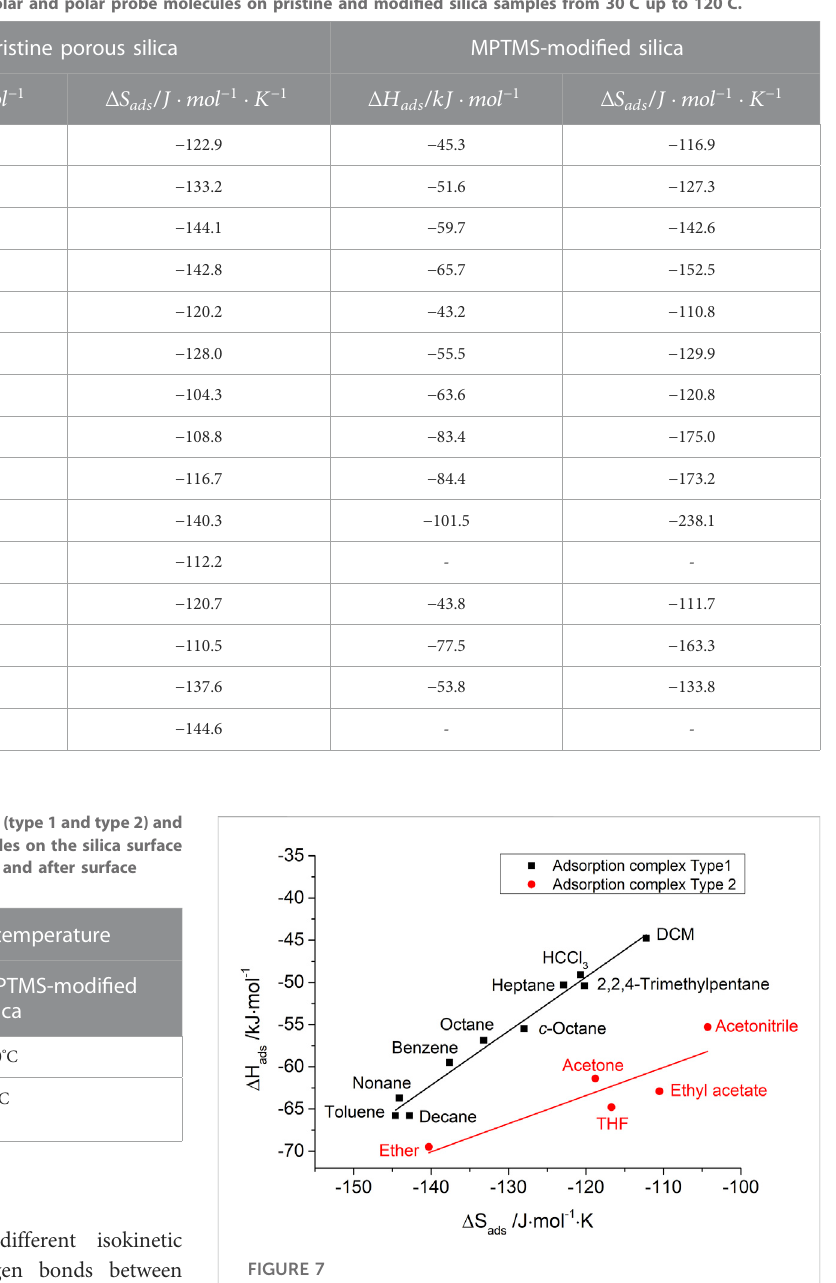
TABLE 3 Estimated Δ H ads and Δ S ads values for non-polar and polar probe molecules on pristine and modi fi ed silica samples from 30 ° C up to 120 ° C.